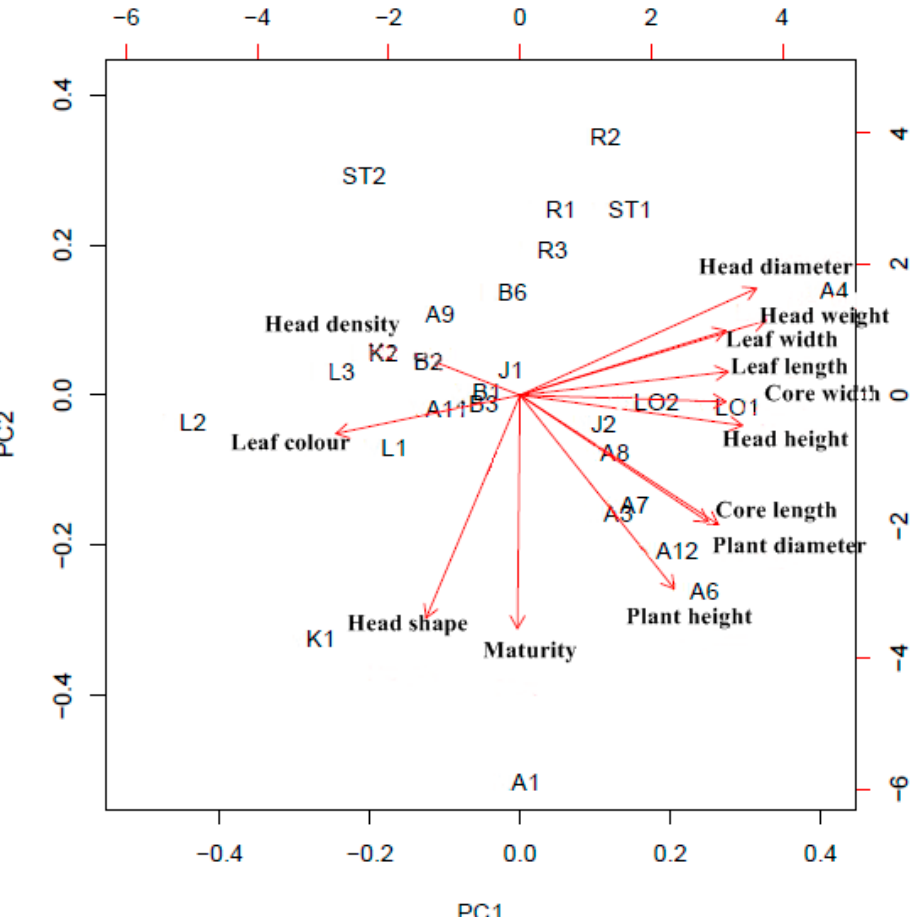
Figure 1. Morphological data: Principal component analysis (PCA) biplot where the descriptors of importance are given as arrows and where the length of an arrow is a measure of the descriptor’s variance and the angle between arrows is a measure of the correlation between descriptors, with a small angle expressing a high correlation. PC1 and PC2 explain 42% and 23% of the total variation. Accession names are abbreviated as codes; see Table 1.